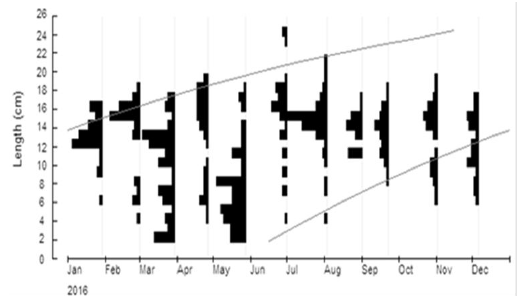
Figure 5. Frequency distribution by monthly length classes with estimated cohorts (blue lines) for P. mana- guensis at the Saco I dam, Pernambuco-Brazil.